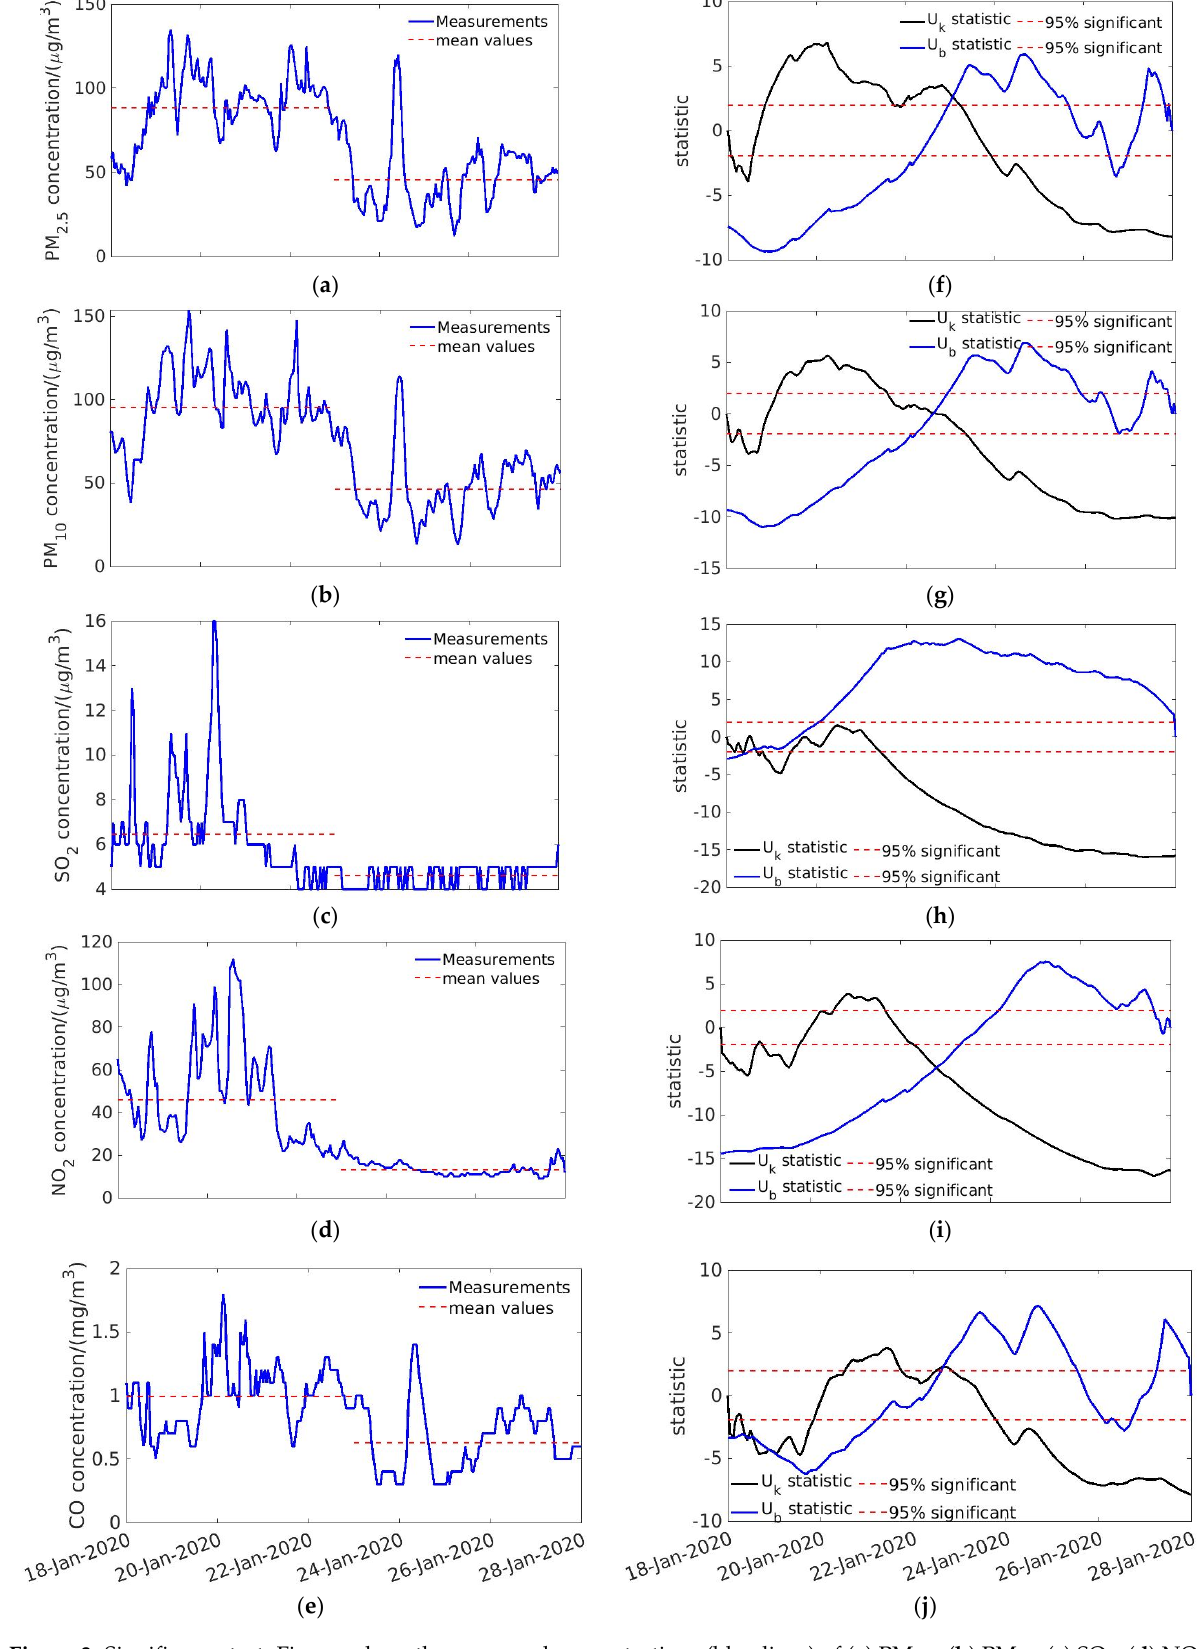
Figure 3. Significance test. Figures show the measured concentrations (blue lines) of ( a ) PM 2.5 , ( b ) PM 10 , ( c ) SO 2 , ( d ) NO 2 , ( e ) CO at Tianhe Station between 18 and 28 January. The red dash lines refer to the mean concentration before and after the lockdown. ( f − j ) shows the significance tests of concentration sequence corresponding to the pollutants.